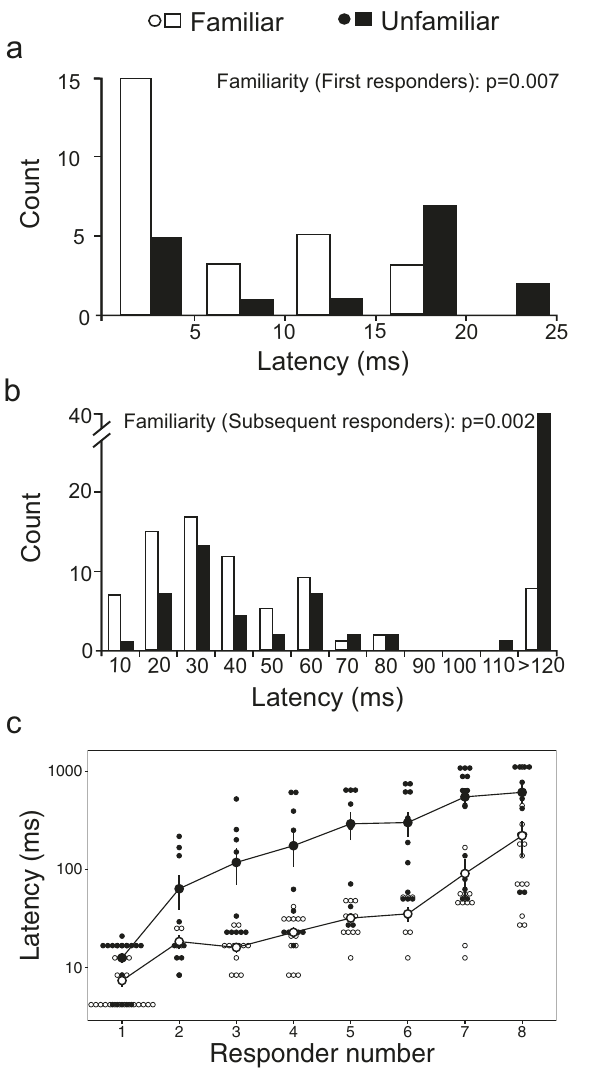
Fig. 2 The latency of the fast-start escape response in familiar versus unfamiliar schools of the damsel fi sh Chromis viridis . Frequency histograms of response latencies for fi rst responders ( a ) and subsequent responders ( b ). c Response latencies by responder number, the sequential order of latencies in each fi sh ’ s respective group. Each larger dot represents the mean ± s.e. ( y axis logged for illustration), with small dots indicative of individual data points. p -values indicate results of the generalised linear model ( a ) and linear mixed-effects model ( b , c ) analyses ( n = 24 schools, composed of 8 fi sh each).